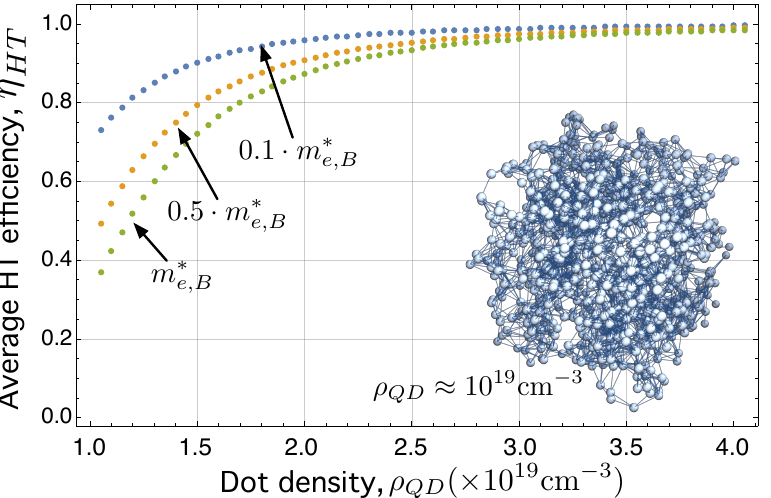
Figure 6. Average hopping transport efficiency (computed over 50 network realizations), η electron HT network, G LCS eHT , as a function of the QD density, ρ QD (cm) ∗ values of m e , B , the electron effective mass in the barrier or in the ligand, depending on the nature of the colloidal quantum